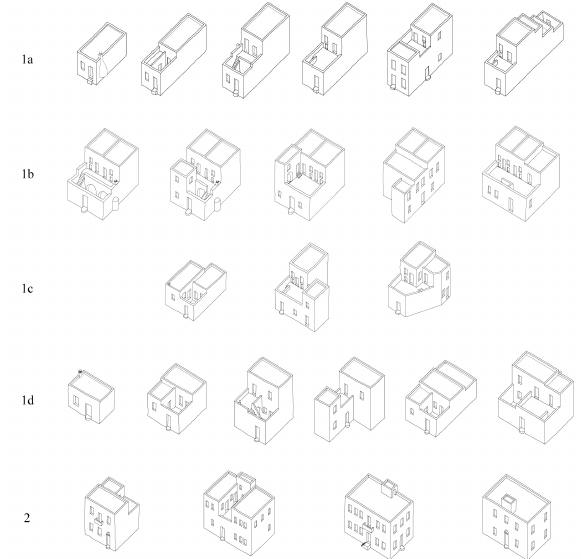
Figure 8. Architectural main typologies and variants.